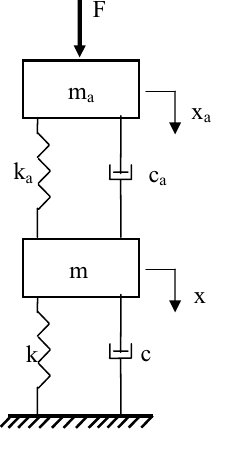
Fig. 1. Mass–spring–damper system.